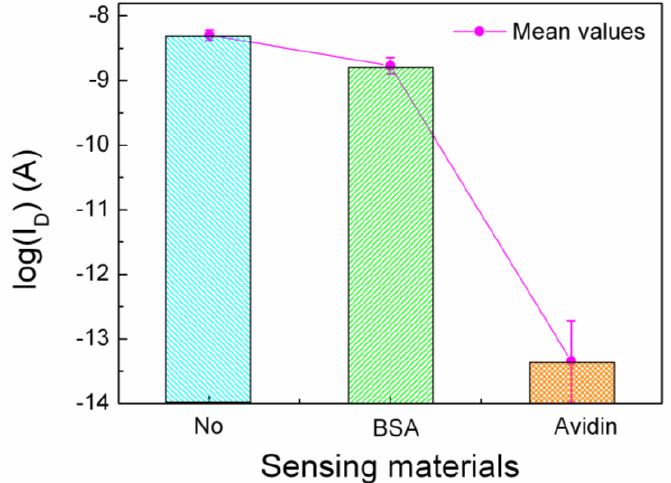
Figure 5. Changes of the drain current of OTFT by the detection of sensing materials. (No): after treatment with DI water. (BSA): after treatment with BSA-solution. (Avidin): after treatment with avidin-solution.